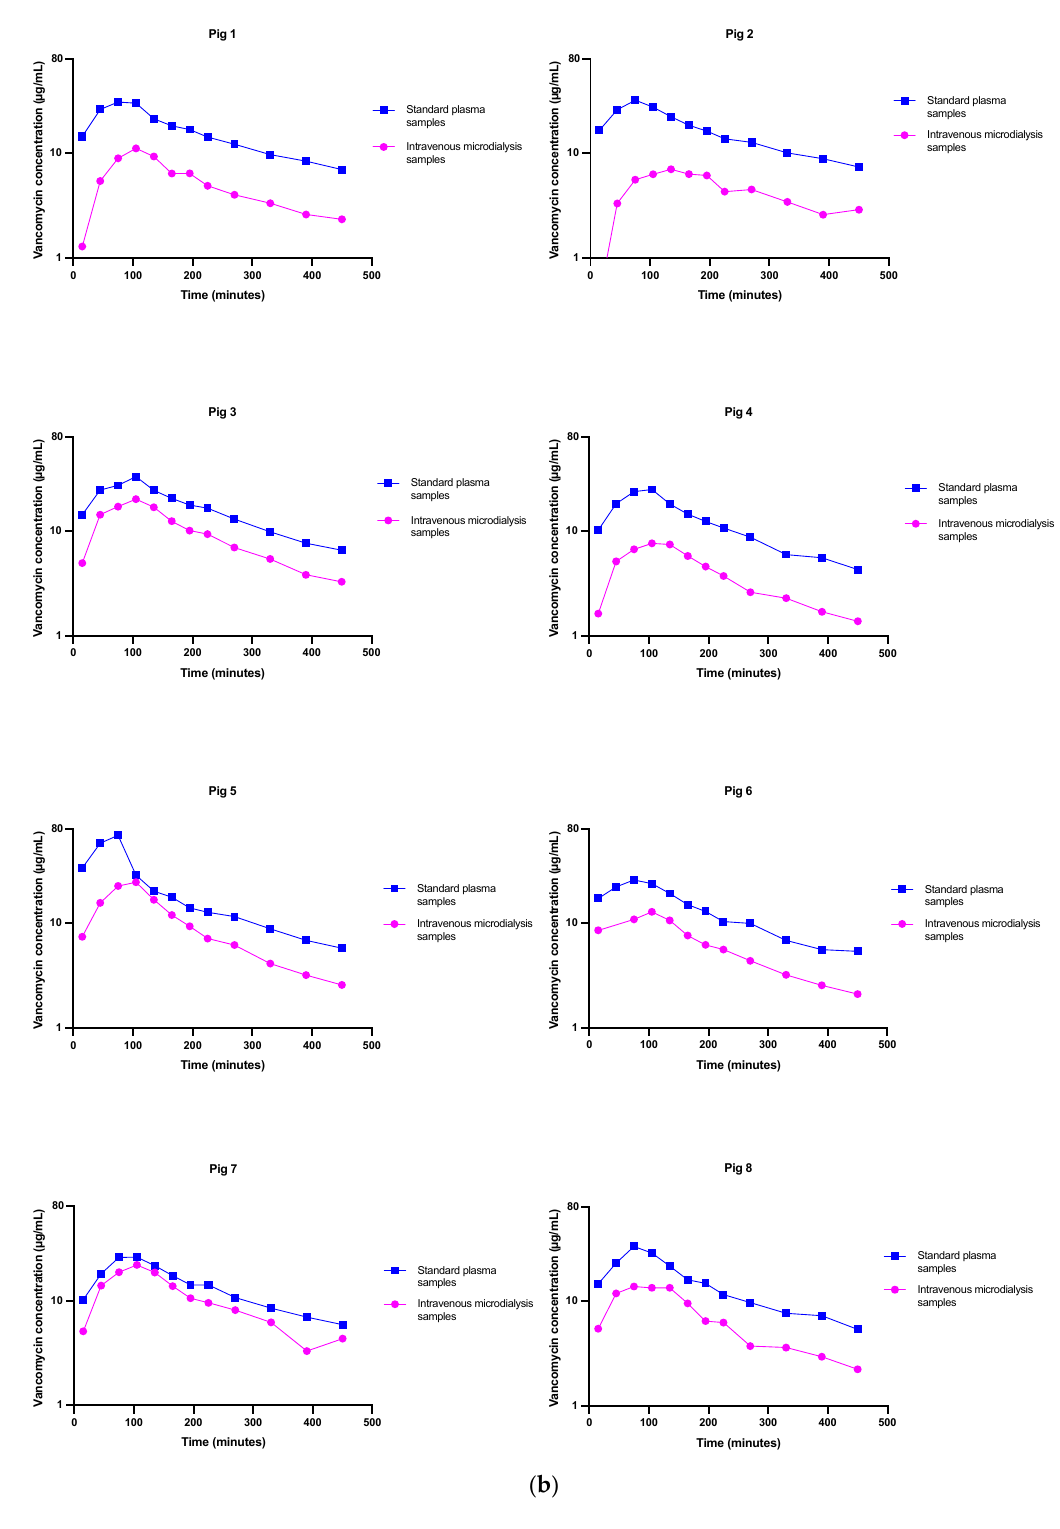
Figure 1. ( a ) Mean concentration–time profiles of vancomycin obtained by standard plasma samples and intravenous microdialysis samples. Standard deviation (SD) is visualized with bars. The left Y -axis is log-scaled and shows a two-segmented axis in order to contain all values. Lower limits of quantification (LOQ) for the analytical methods are inserted for illustration. ( b ) Individual concentration–time profiles for standard plasma sampling and intravenous microdialysis sampling in pig numbers 1–8 for vancomycin. The Y -axis is